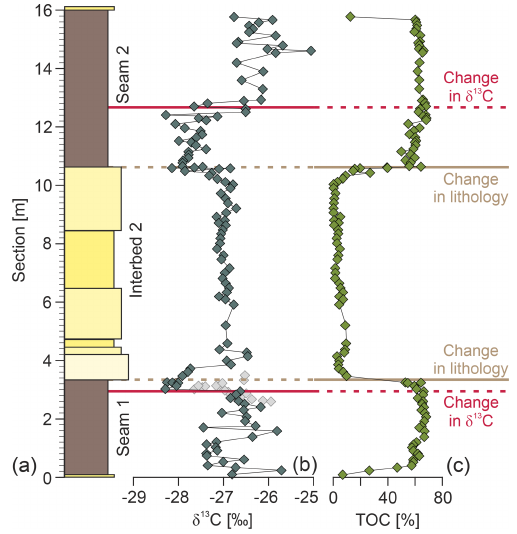
Figure 2. (a) Composite stratigraphic section, (b) δ 13 C values of bulk organic matter, and (c) total organic carbon (%TOC). Lines denote lithological changes between the marine interbed and the lignite seams (brown) and changes in δ 13 C values independent of lithological changes